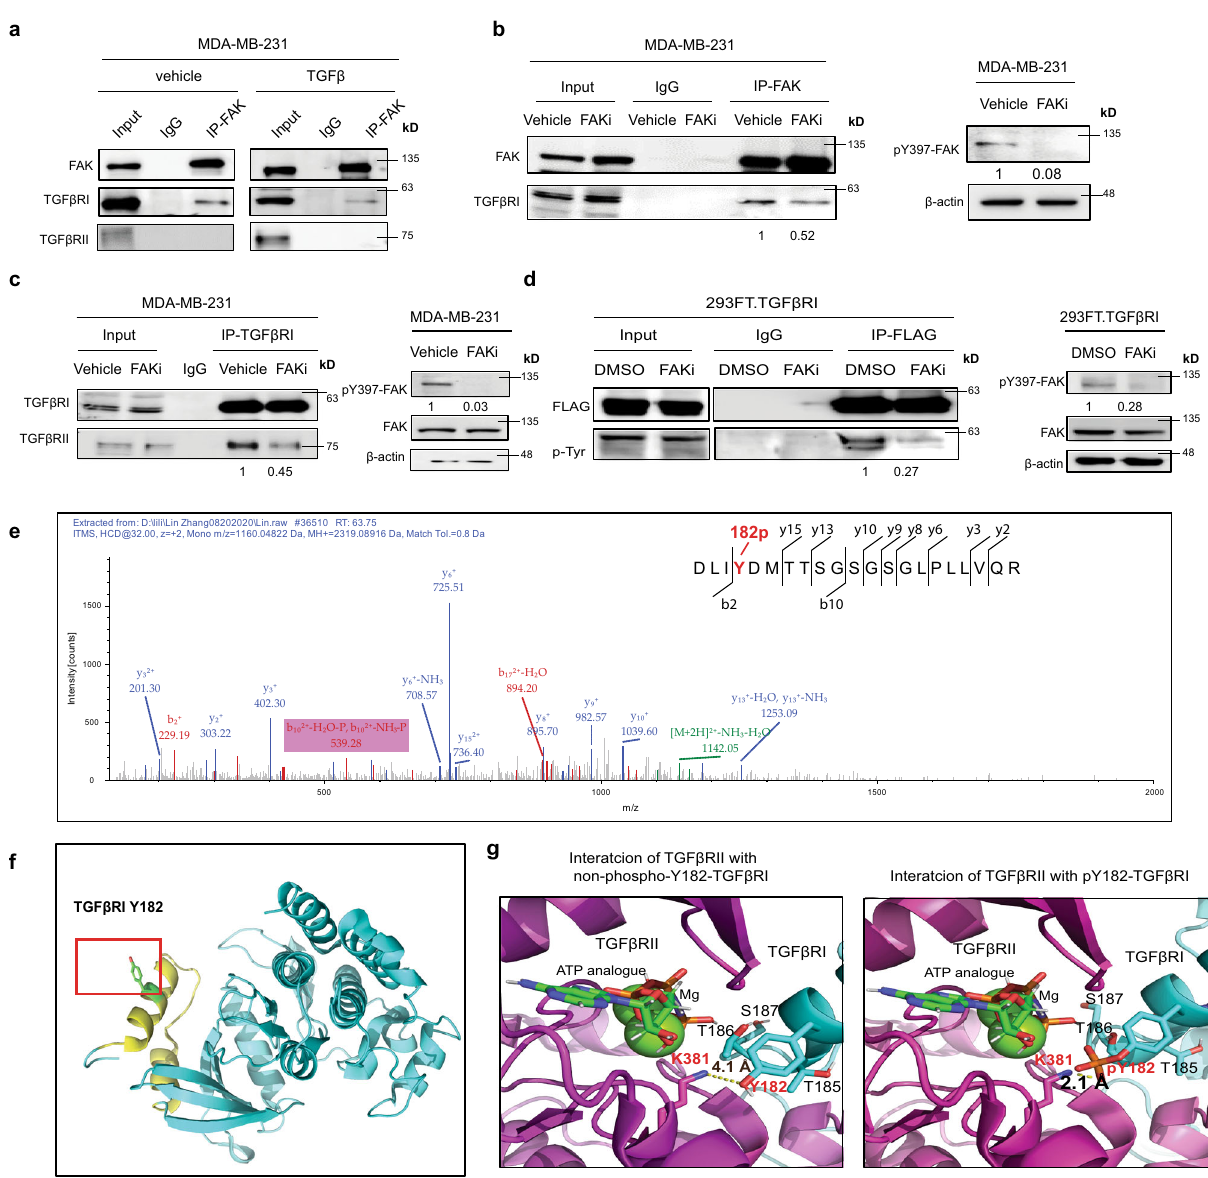
Fig. 4 pY397-FAK induces TGF β RI tyrosine phosphorylation that enhances its binding to TGF β RII in response to TGF β . a IP of FAK from the lysis of MDA-MB-231 cells treated with a vehicle or TGF β (5 ng/mL) for 2 h followed by western blotting for FAK, TGF β RI, and TGF β RII. b IP of FAK from the lysis of MDA-MB-231 cells treated with a vehicle or the FAKi VS-4718 (1 μ M) for 24 h followed by western blotting for FAK and TGF β RI. c IP of TGF β RI from the lysis of MDA-MB-231 cells treated with a vehicle or the FAKi VS-4718 (1 μ M) for 24 h followed by western blotting for TGF β RI and TGF β RII. d IP of FLAG from the lysis of MDA-MB-231 cells treated with a vehicle or the FAKi VS-6063 (10 μ M, 24 h), followed by western blotting for phospho-Tyrosine (p-Tyr). e Mass spectrometric analysis showing integrin β 1 tyrosine (Y) – 182 phosphorylation. f The orientation of Y182 was illustrated in the cartoon diagram of TBF β RI structure (PDB ID: 1ias) as generated using PyMOL. The GS domain of TBF β RI is colored in yellow. g Close-up view of the interaction interfaces of docked complex model between TGF β RII (PDB ID: 5e92) and TGF β RI (PDB ID: 1ias) without (top)/with (bottom) Y182 phosphorylation, obtained through protein – protein docking using ClusPro